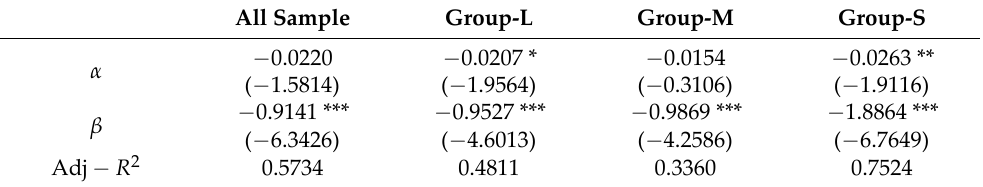
β Table 2. Test for -convergence of energy intensity. Table 2. Test for β ‑convergence of energy intensity.